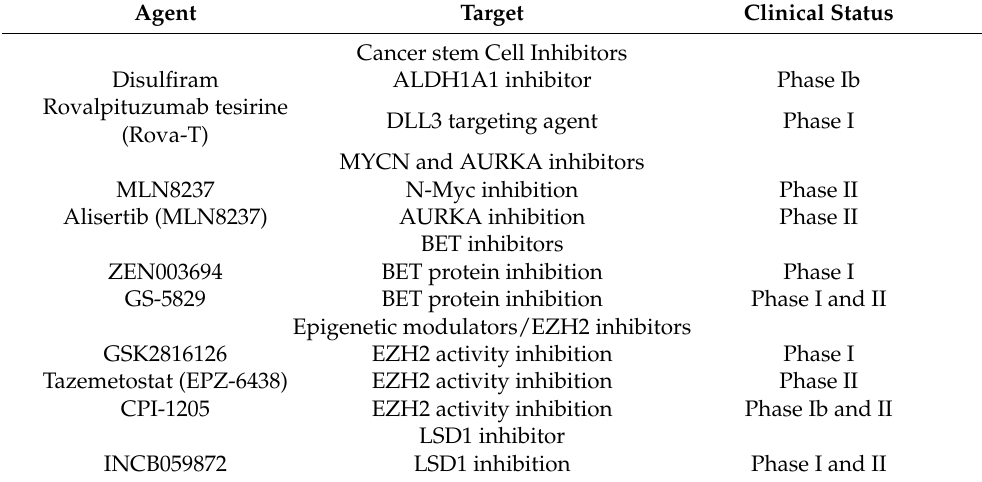
Table 1. Current clinical trials under investigation for NEPC (clinicaltrials.gov (accessed on